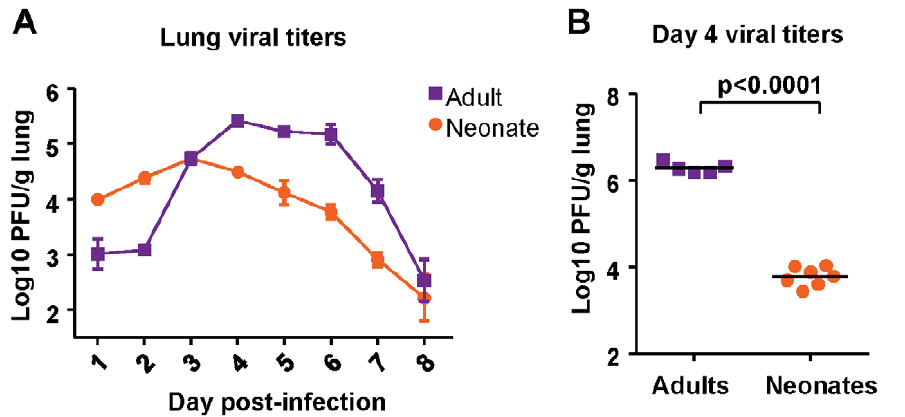
Figure 1. Viral titer kinetics in RSV-infected adult and neonatal mice. (A) Viral titers in the lungs of mice at days 1-8 following infection with 2 6 10 6 PFU of RSV. Error bars represent the SEM. (B) Viral titers in the lungs of adult and neonatal mice at day 4after infection with 1 6 10 7 PFU of RSV. Horizontal bars represent the mean values. Data are representative of experiments performed twice with 4-8 mice/group.